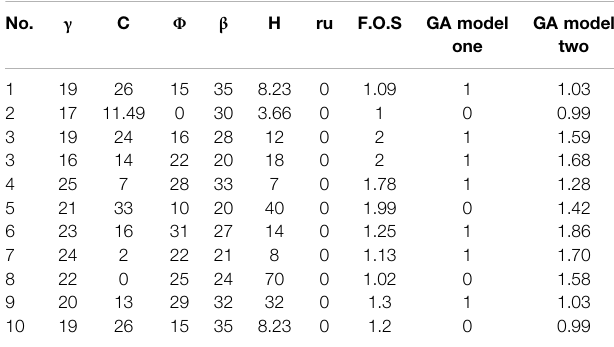
TABLE 4 | Estimating function historical